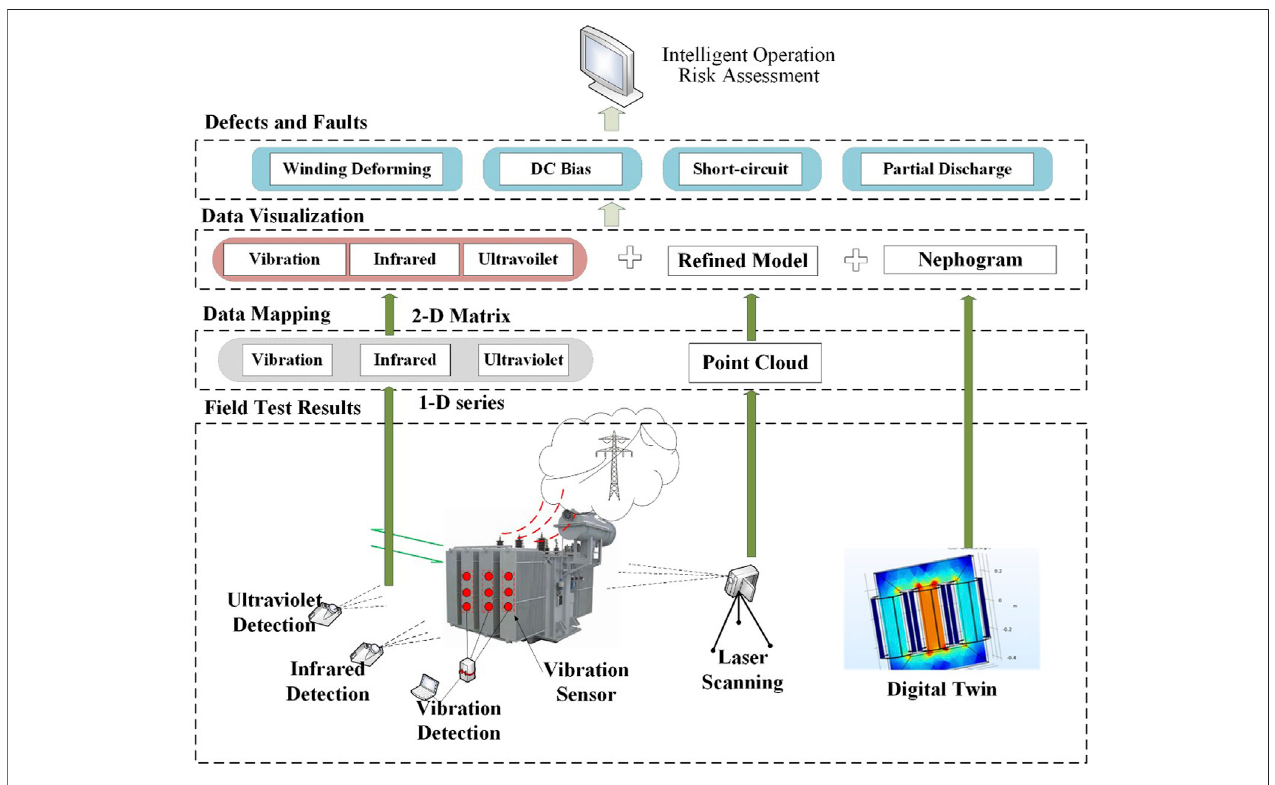
FIGURE 12 | Establishment of digital twin for key equipment in PSH based on the proposed method.